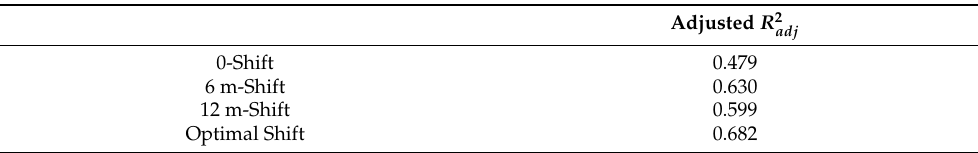
Table 5. R 2 for linear models with different time shifts. adj